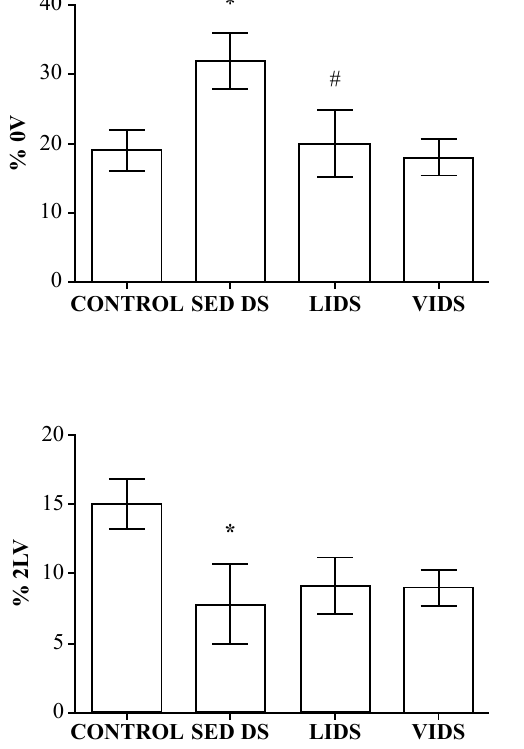
Figure 1. Symbolic representation of autonomic modulation in the frequency domains among